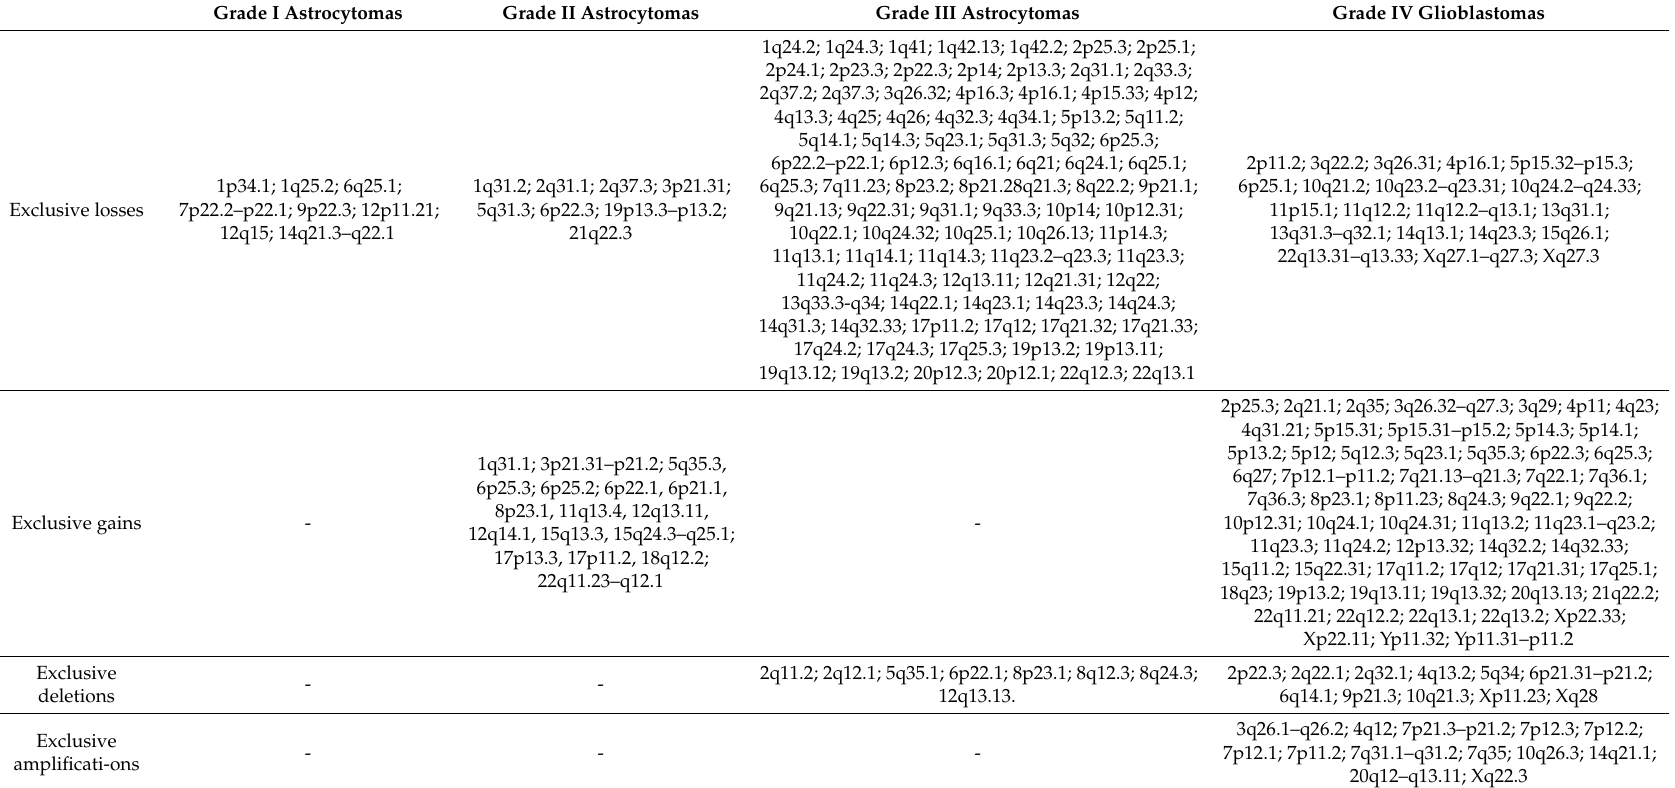
Table 3. Exclusive changes found in different grades of